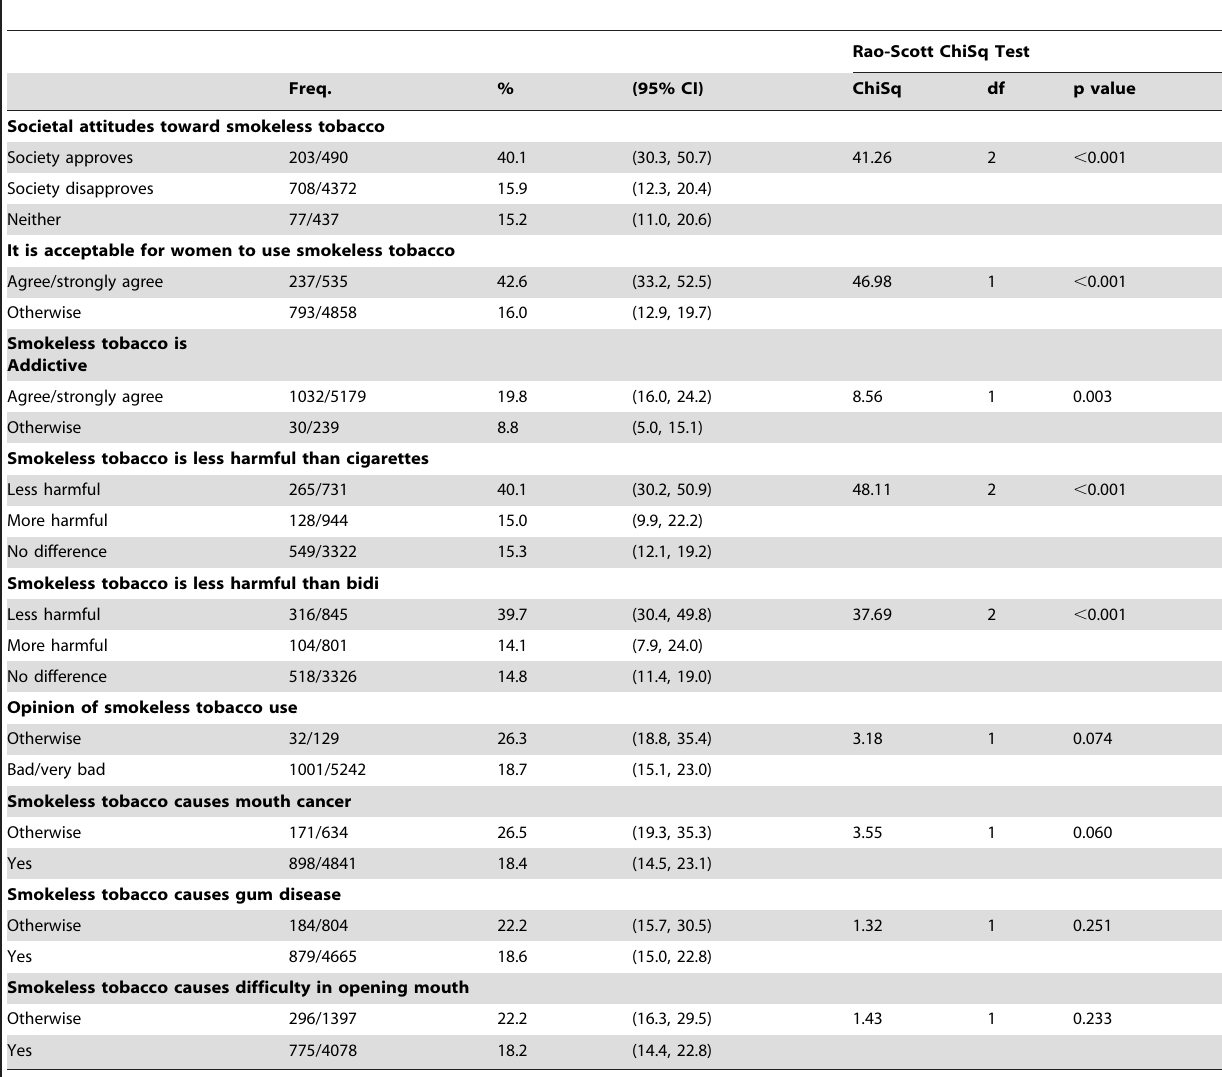
Table 3. Smokeless tobacco use by attitudes toward smokeless tobacco among Bangladeshi residents (weighted),